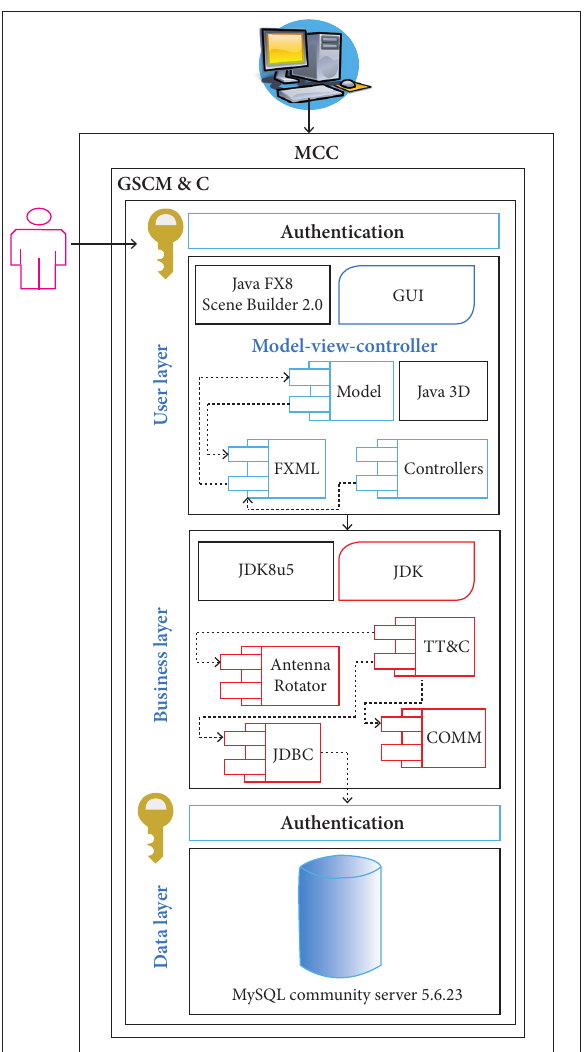
figure 14. Composed structure of the GSCM&C as part of the